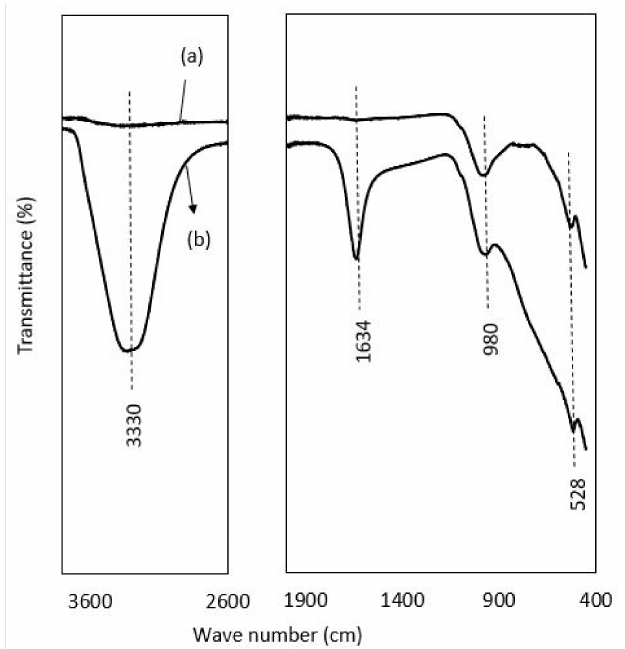
Figure 4. FTIR spectra showing the peak values of transmittance against wave numbers: ( a ) represents the spectra of raw laterite, and ( b ) is the spectra of laterite after adsorption.